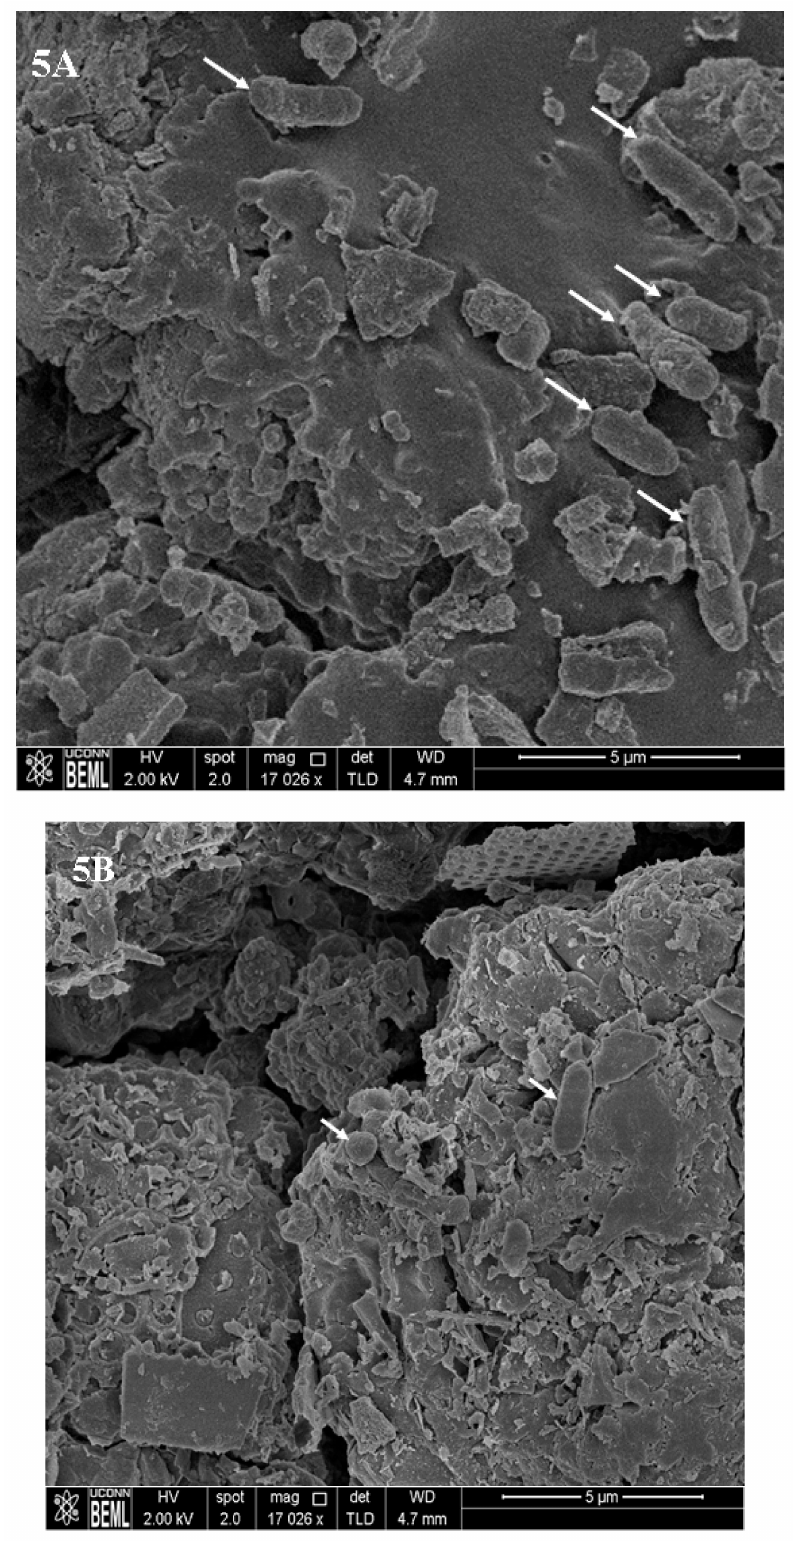
Figure 5. Ultrastructure images of UPEC biofilm on urinary catheters. Catheter pieces (3 cm) were inoculated with UPEC (~6.0 log CFU) and incubated at 37 ◦ C for biofilm formation. The established biofilm was treated with 0 and 85 mM of selenium for an exposure time of 1 day. Following exposure, the catheter pieces were processed for SEM imaging. ( A ) Inoculated catheter without treatment, ( B ) inoculated catheter after selenium treatment. Arrows indicate UPEC cells on the catheter